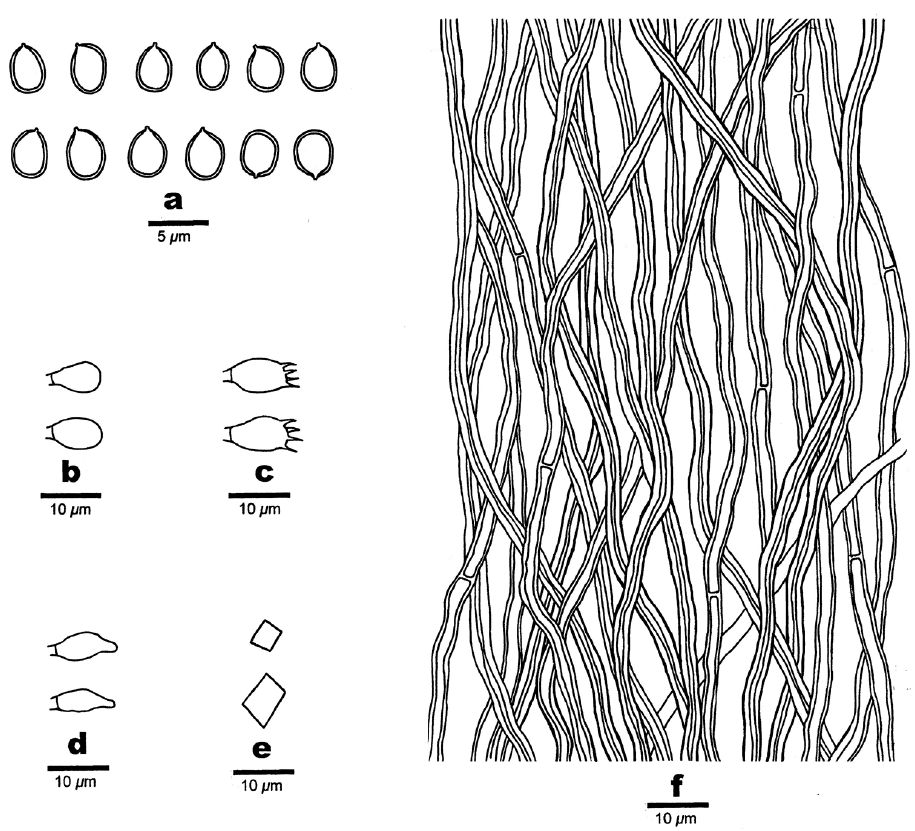
Figure 4. Microscopic structures of Fomitiporella austroasiana . a Basidiospores b Basidioles c Basidia d Cystidioles e Rhomboid crystals f Hyphae from